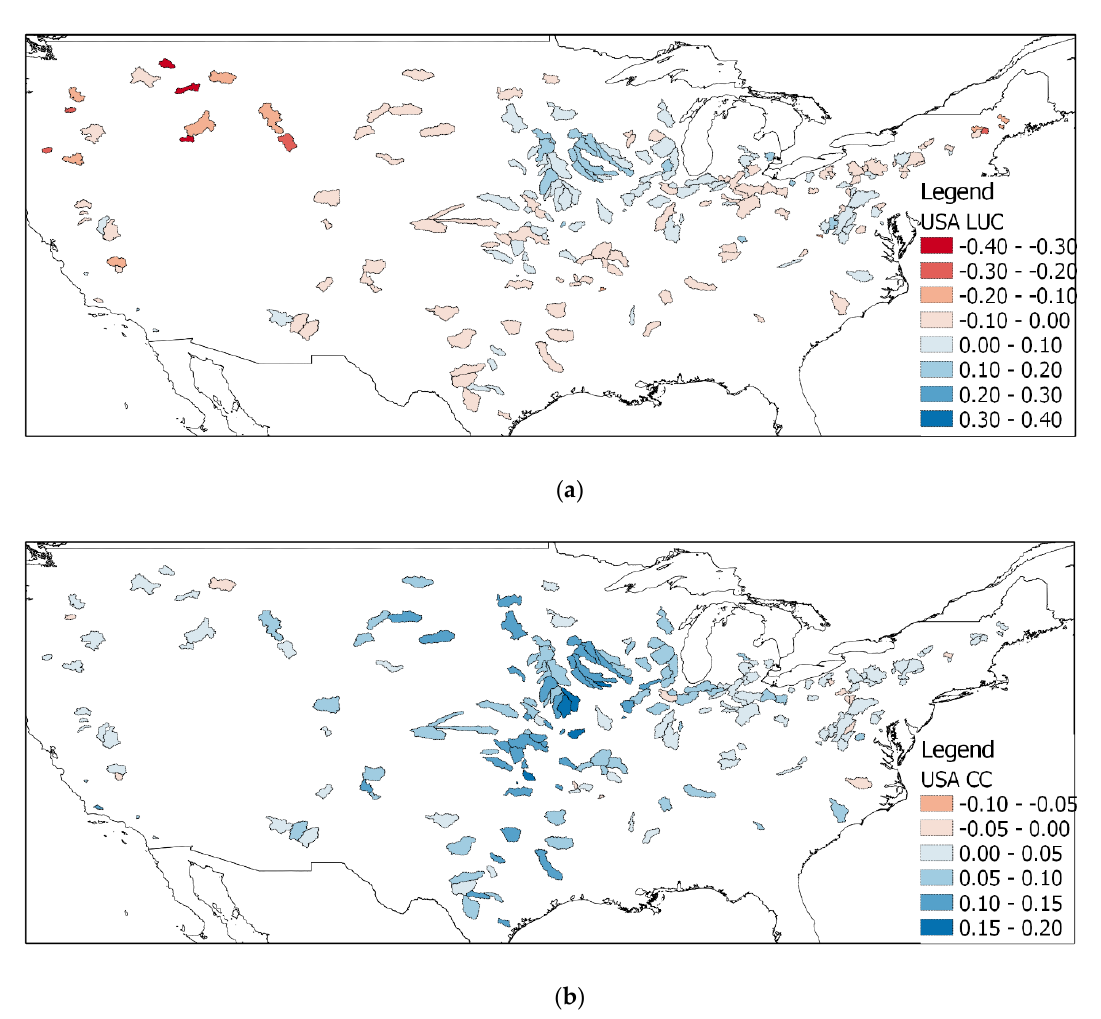
Figure 6. Spatial distribution of LUC ( a ) and CC ( b ) values of the American catchments.